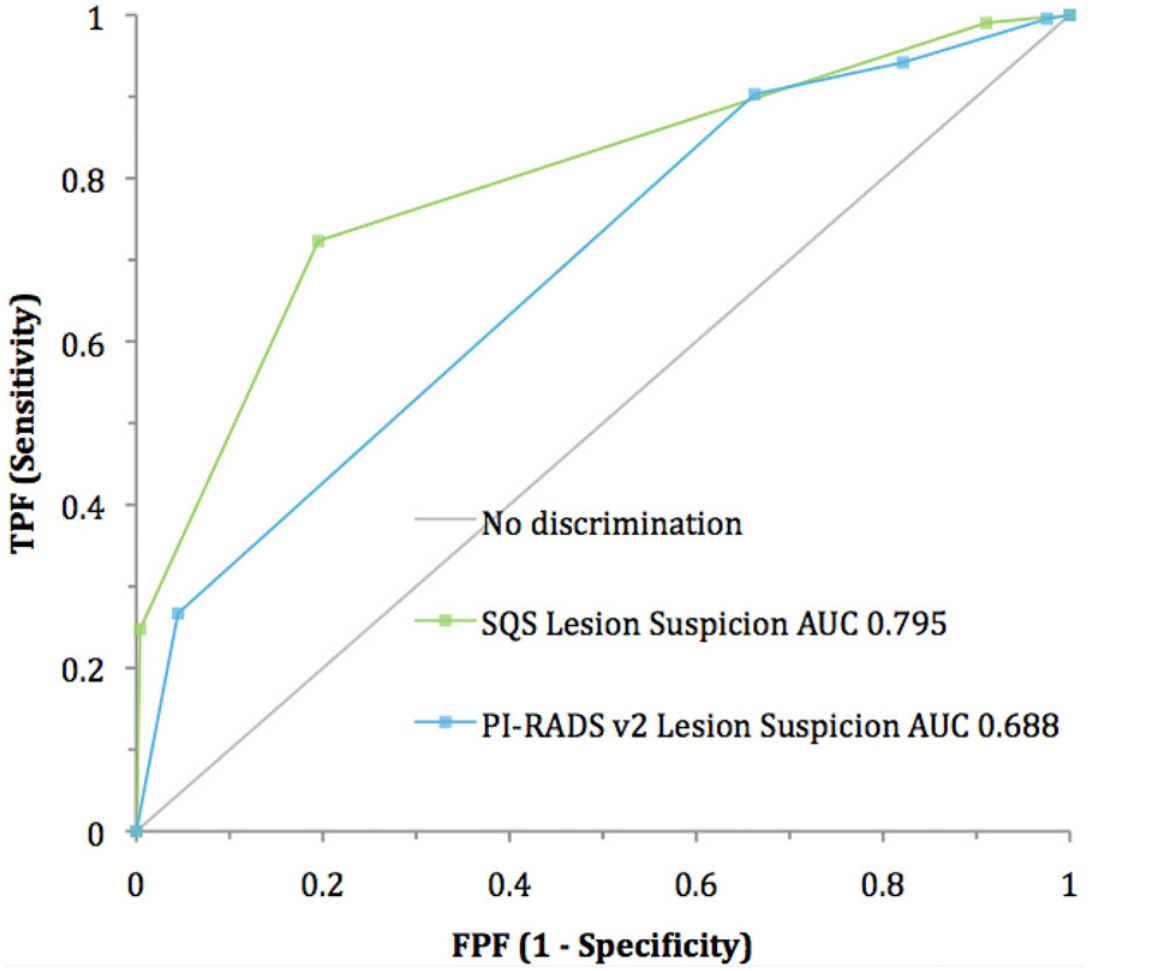
Fig 11. ROC curve analysis: